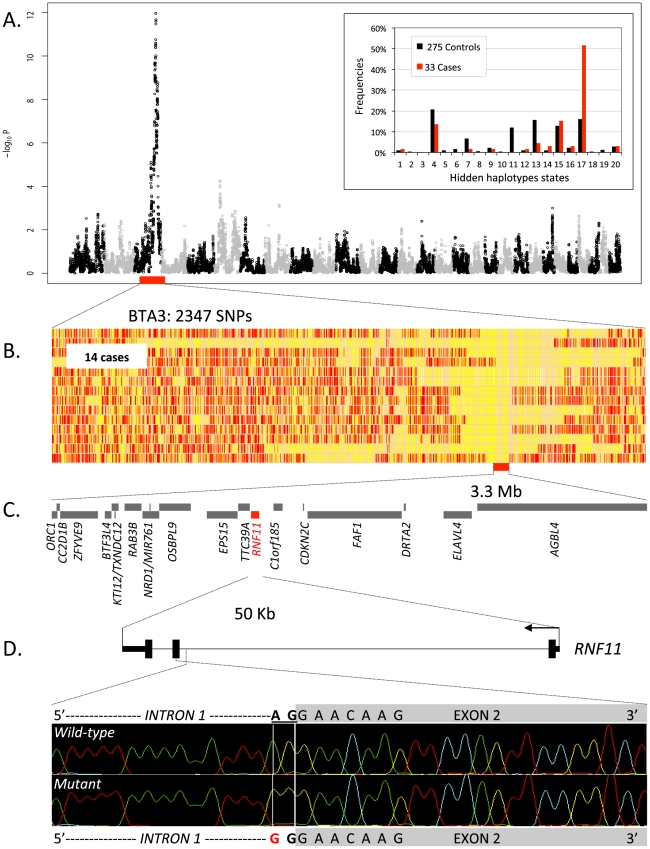
Genome-wide haplotype-based association mapping of a growth stunting locus on BTA 3.(A) Manhattan plot for the haplotype-based genome-wide association study for stunted growth using a model with 20 ancestral haplotypes. Alternating colors (black and grey dots) mark the limits between autosomes. Inset: frequency of the 20 hidden haplotype states in the 33 cases (red) and the 275 controls (black) at position BTA3:103,391,968 bp. (B) Genotypes of the 14 cases homozygous for hidden haplotype state 17 for 2,347 BTA3 SNPs. Homozygous genotypes are shown in orange or yellow and heterozygous genotypes in red. The limit of the homozygous haplotype shared by the 14 cases is highlighted in red. (C) Gene content of the 3.3 Mb shared interval (19 genes). (D) RNF11 gene model, and representation of the RNF11 c124-2A>G splice site variant.